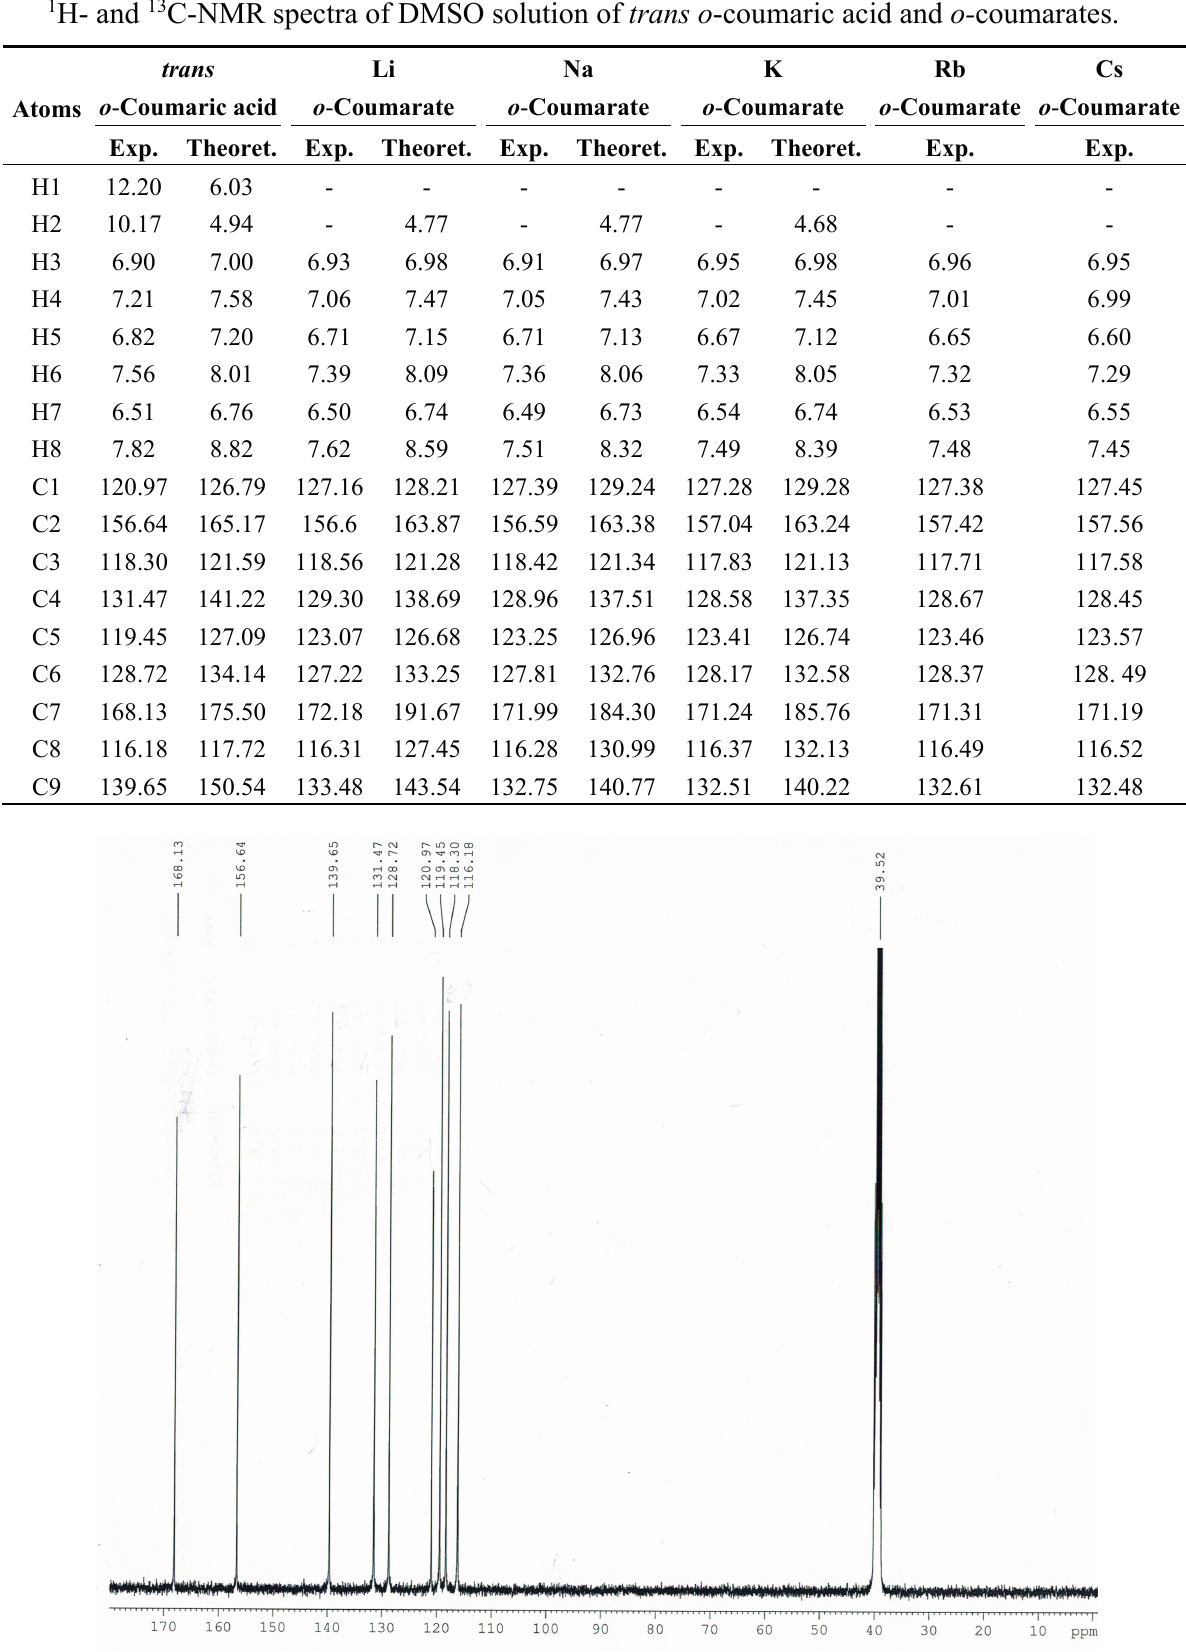
Table 4. Experimental and calculated (B3LYP/6-311++G**) chemical shifts [ppm] in